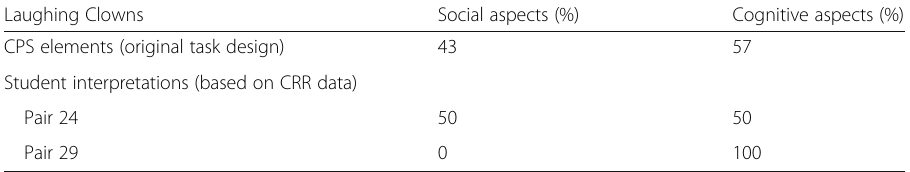
Table 7 Relative frequency distributions of social and cognitive aspects (Laughing Clowns) Laughing Clowns Social aspects (%) Cognitive aspects (%)